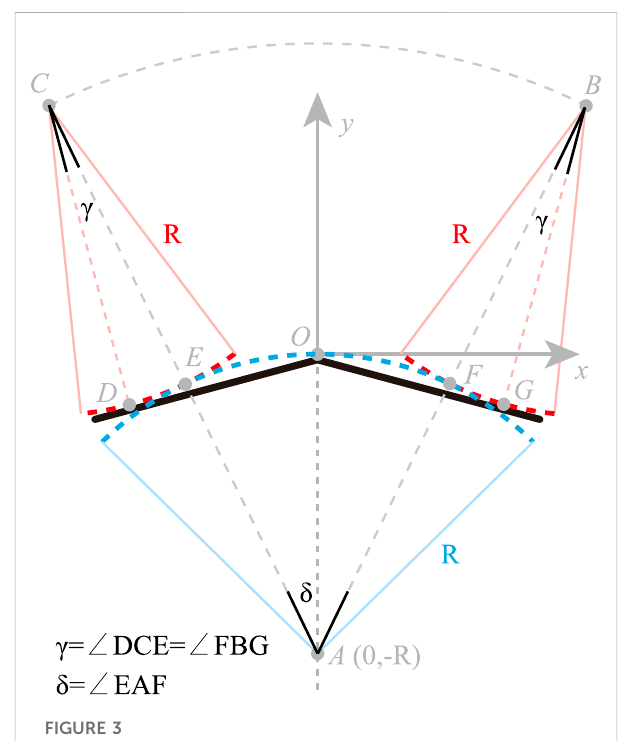
FIGURE 3 Schematic diagram for calculating the largest deformation ratio of the kirigami-inspired